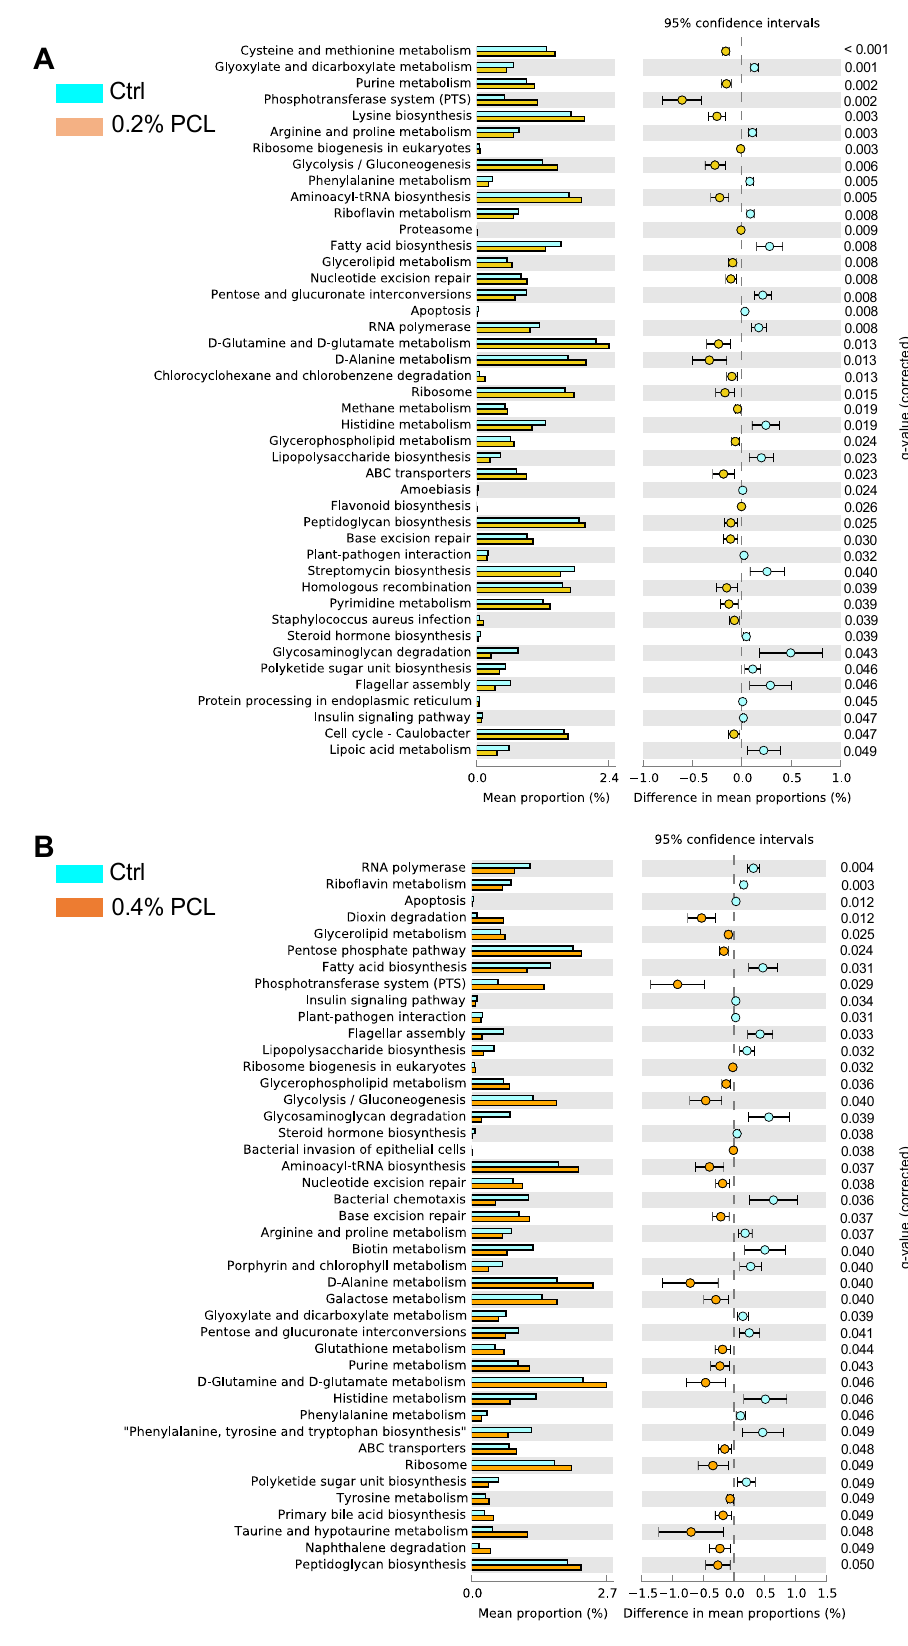
Figure 6. Prediction of bacterial genes’ functions to make inferences from KEGG annotated databases using PICRUSt analysis. The gene abundances of the metabolic pathways significantly affected by